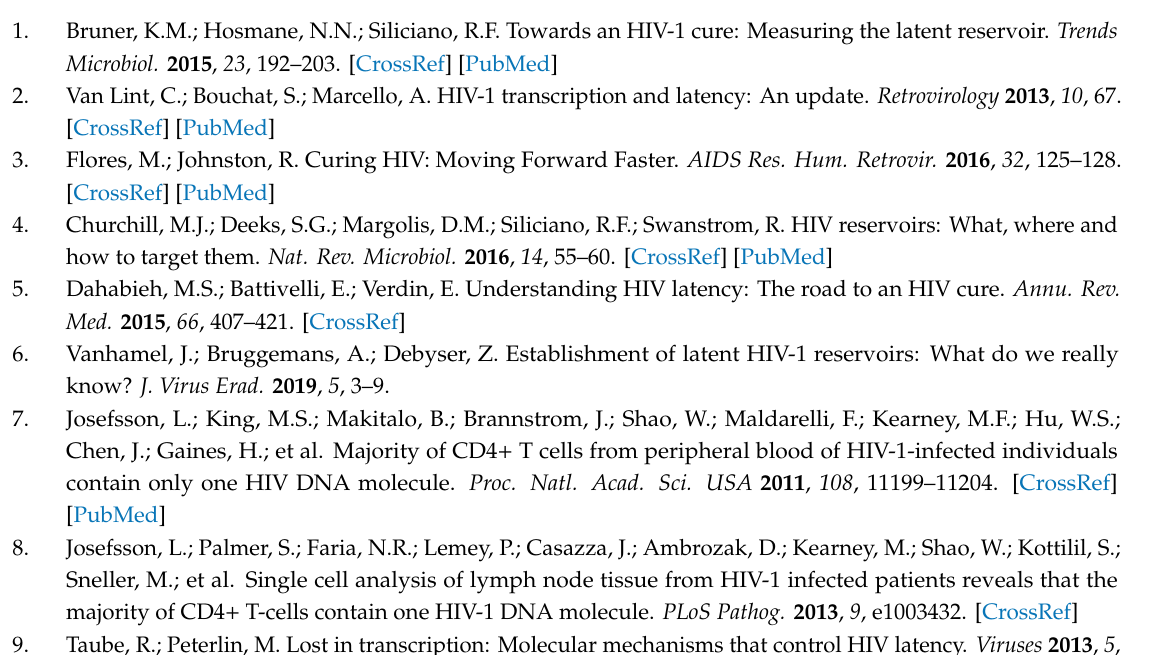
Figure S1: E ff ect of LRAs in combination on the reactivation of latent HIV measured using flow cytometry, Figure S2: E ff ect of combinations of LRAs on HIV gp120 expression following 24 h and 48 h treatment. Figure S3: E ff ect of combinations of LRAs on CD4 and CD3 expression measured using flow cytometry. Figure S4: Evaluation of combinations of di ff erent concentration of prostratin and AR-42 using flow cytometry. Figure S5: E ff ect of LRA combinations on cellular activation. Table S1. Comparison of the e ff ect of the LRA combinations on di ff erent experimental